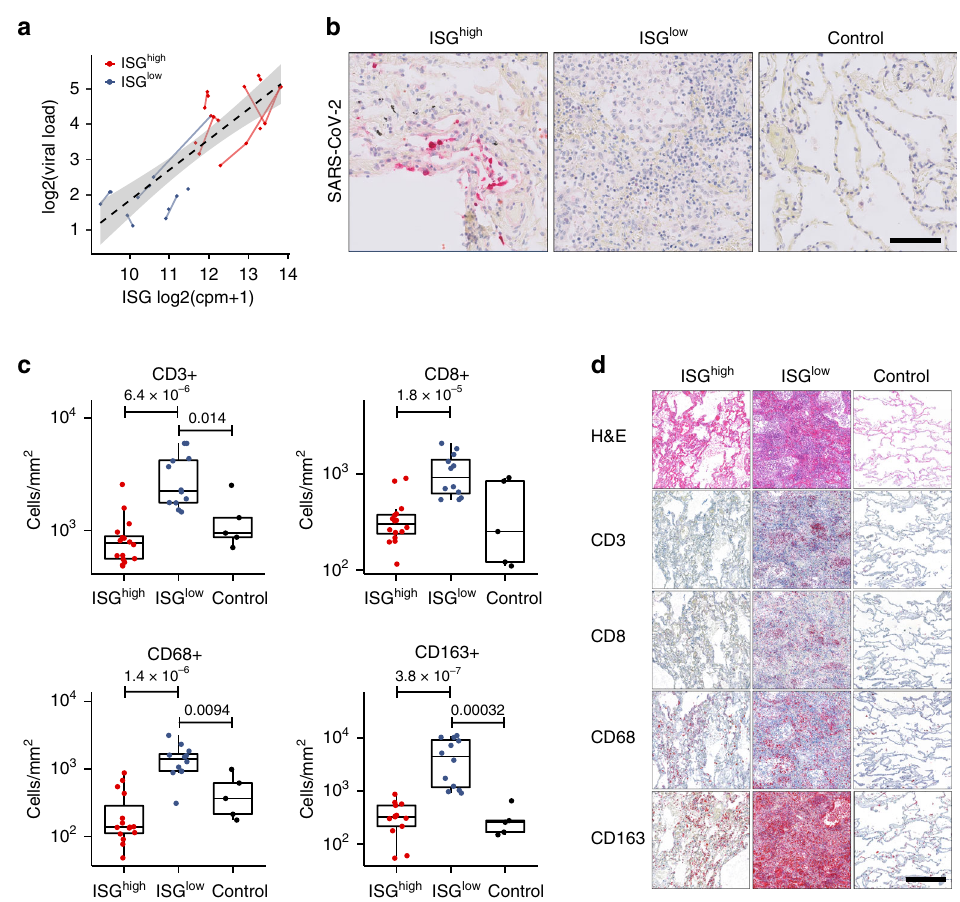
Fig. 3 Virological and cellular characteristics of the ISG high and ISG low COVID-19 lung pro fi les. a Correlation of viral load and ISG expression in COVID- 19 lungs. Solid lines connect sample points from the same patient. The dotted line shows a regression for all samples, and the gray area delimits the 95% con fi dence intervals around it (Pearson ’ s correlation = 0.83, adjusted R -squared = 0.68, p -value = 1.66e − 08). b Representative immunohistochemistry for SARS-CoV-2 on ISG high and ISG low COVID-19 lung samples and controls. Size bar 100 μ m. At least two different tissue blocks from different areas of the lungs were evaluated for each case. c Frequencies of immune cells on ISG high and ISG low COVID-19 lung sections and controls. ( n = 33 for CD3 and CD8, n = 32 for CD68, n = 30 for CD163). Box-plots elements indicate the median (center line), upper, and lower quartiles (box limits). Whiskers extend to the most extreme value included in 1.5× interquartile range. Groups were compared using a two-sided Wilcoxon rank-sum test. d Representative H&E stains and immunohistochemistry (CD3, CD8, CD68, CD163) of ISG high and ISG low COVID-19 lungs and controls, size bar 500 μ m. At least two different tissue blocks from different areas of the lungs were evaluated for each case. ISG high samples, red; ISG low samples,